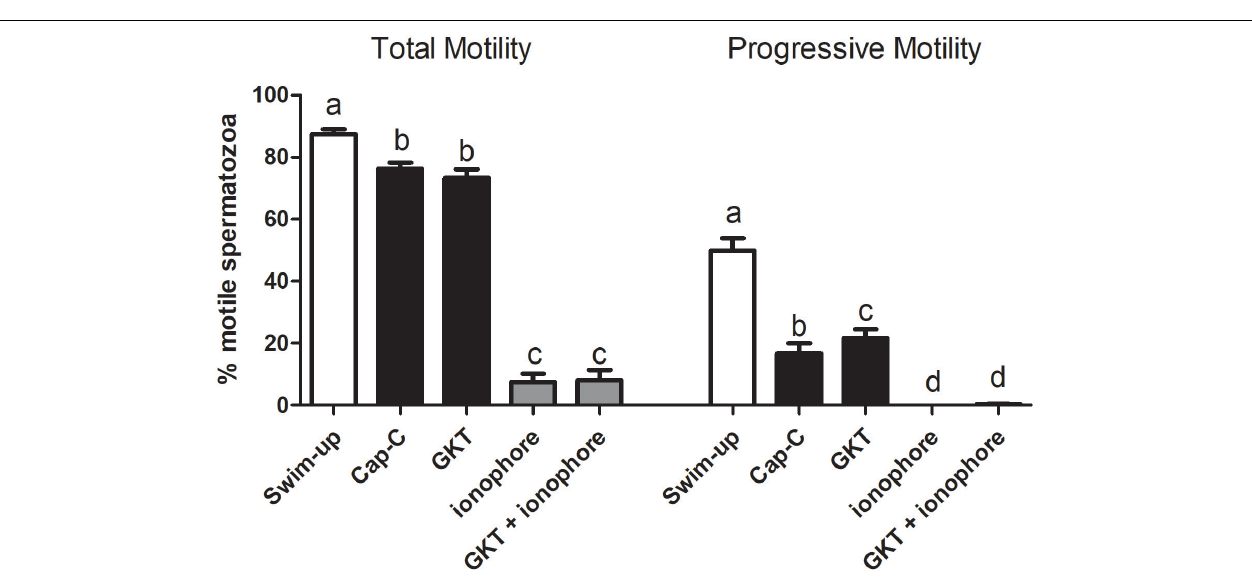
FIGURE 5 | Percentage of total motile (left) and progressive (right) spermatozoa before (swim-up, white bars) and after in vitro capacitation with cAMP-elevating agents (Cap-C, black bars) and with GKT136901 (GKT, 1 µ M) or/and calcium ionophore A23187 (ionophore, 1 µ M, gray bars). Data are shown as mean ± SEM ( n = 6). Different letters indicate significant differences ( p <